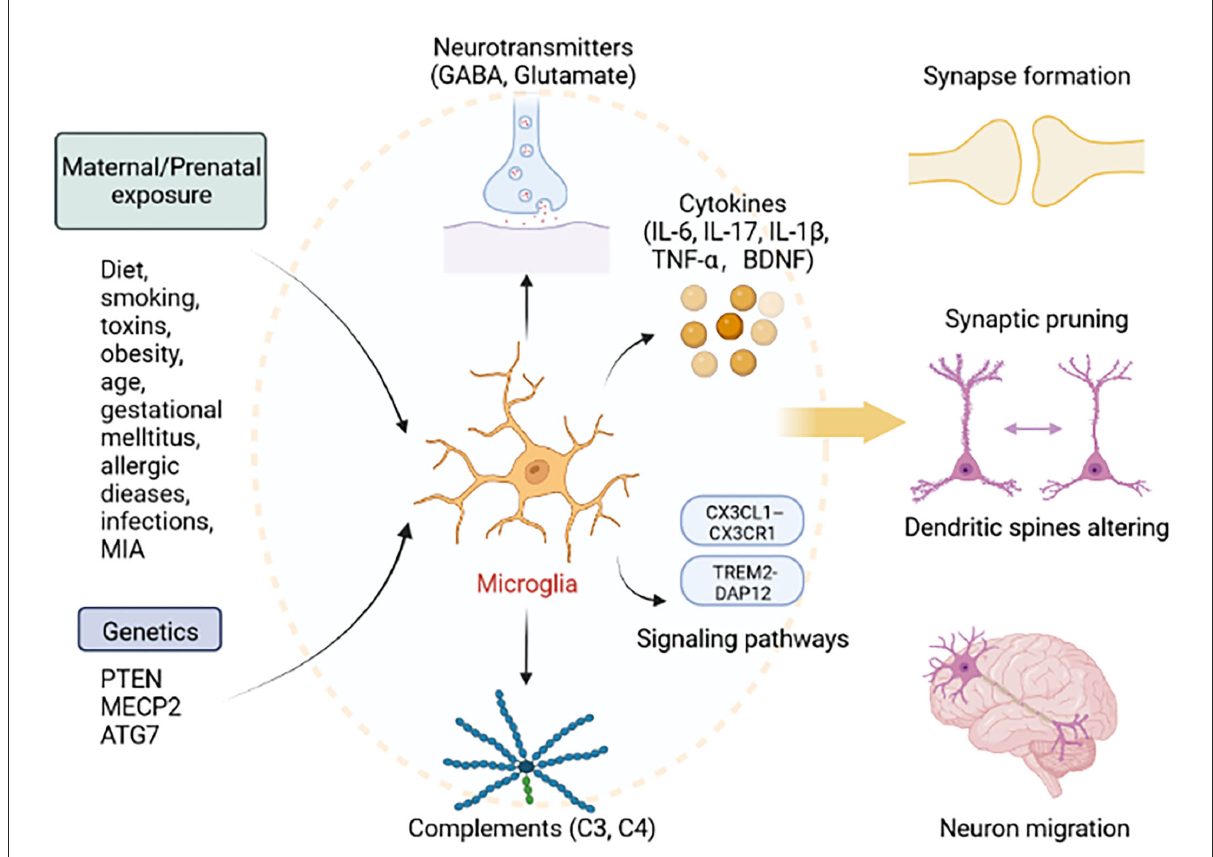
FIGURE1 Roles of microglia in ASD. Exposure to factors during pregnancy, including diet, smoking, toxins, obesity, age, gestational mellitus, allergic diseases, infections, MIA, and genetic factors, including mutations in PTEN, MECP2, and ATG7, can lead to abnormal microglial function. Microglia can secrete cytokines (IL-6, IL-17, IL-1 β , TNF- α , and BDNF), neurotransmitters (GABA, Glutamate), and complements (C3 and C4), and activate signaling pathway (TREM2-DAP12 and CX3CL1–CX3CR1). Thus, activated microglia lead to the abnormal development of synapse formation, synaptic pruning, dendritic spines altering, and neuron migration. This figure was created with